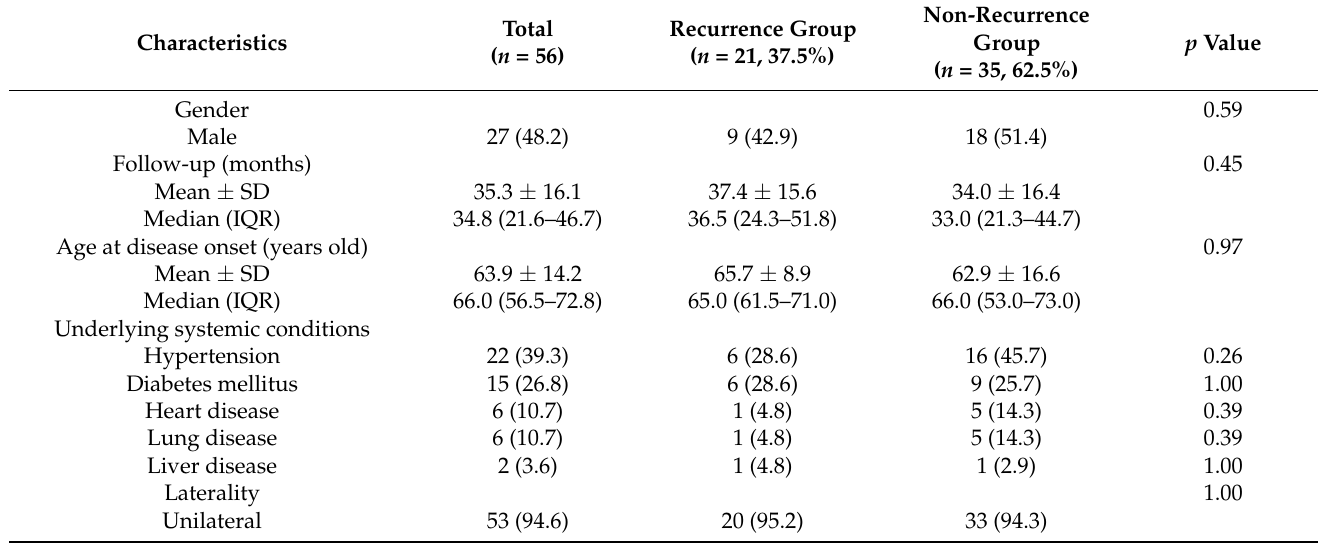
Table 1. Characteristics of the Study